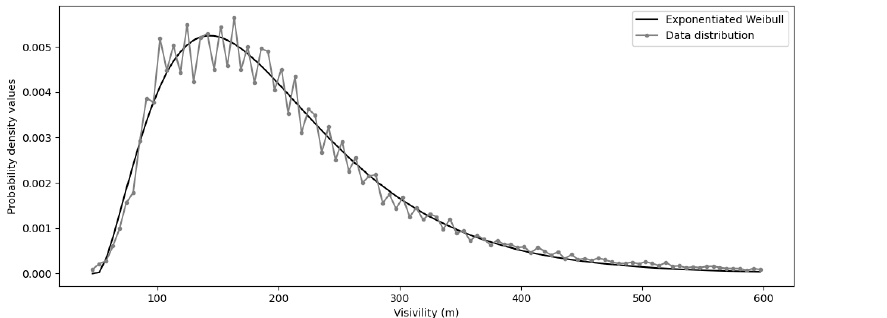
Figure 4. Probability functions of complete low visibility event data and the exponentiated Weibull